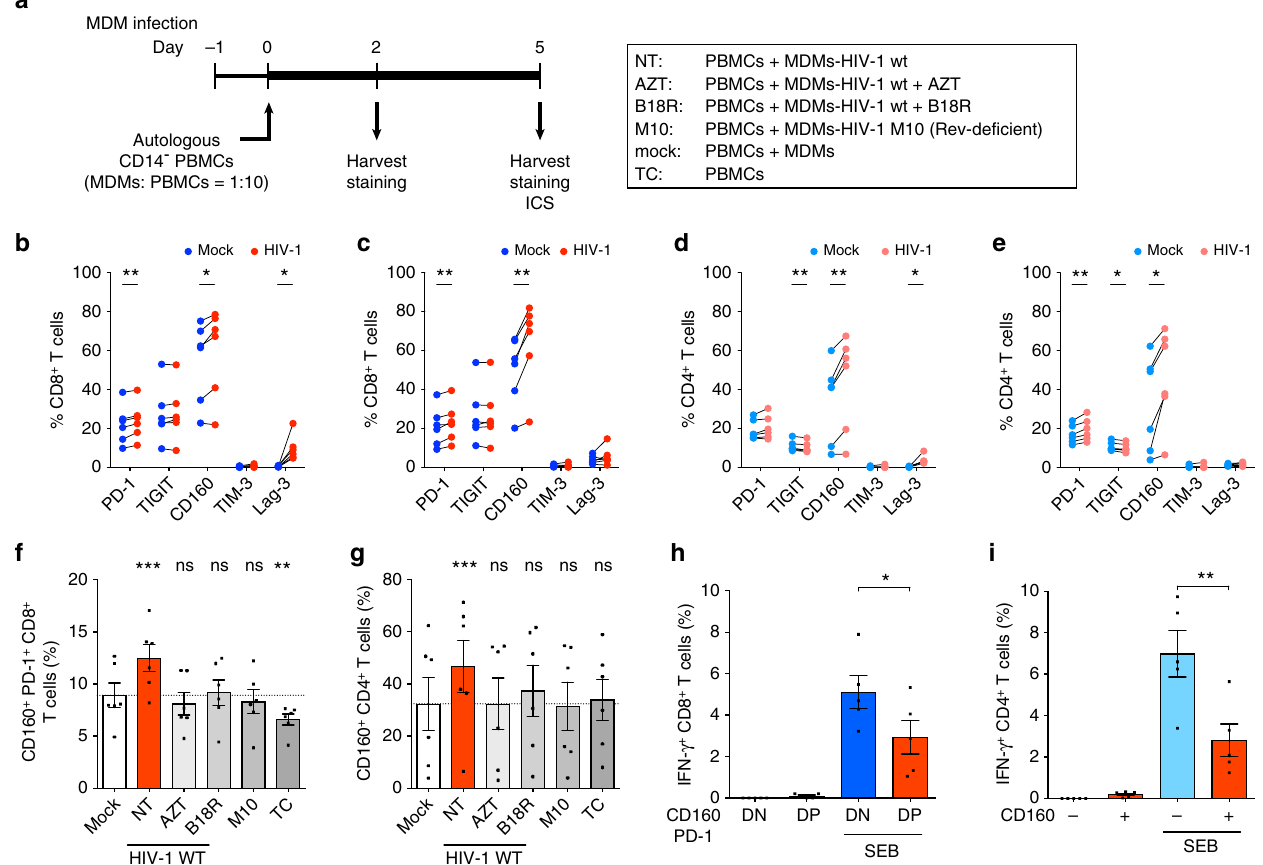
Fig. 6 HIV-1-infection-induced MDM activation results in T-cell dysfunction. a Schematic of T-cell exhaustion immune phenotyping and intracellular cytokine staining (ICS) assay. MDMs were infected with Lai Δ envGFP/G (MOI of 2, wt Rev or M10 Rev) in the presence or absence of AZT or B18R, and autologous CD14 - PBMCs were added to MDMs on day 1 post infection (MDM:PBMC ratio = 1:10). b – g The percentage of IR + CD8 + T cells on day 2 ( b ) or day 5 ( c ), or IR + CD4 + T cells on day 2 ( d ) or day 5 ( e ) post initiation of co-culture. f , g The percentage of CD160 + PD-1 + CD8 + T cells ( f ) and CD160 + CD4 + T cells ( g ) on day 5 post initiation of co-culture. The dotted lines indicate the background levels (mock). h , i The percentage of IFN- γ producing CD160 + PD-1 + (DP) or CD160 - PD-1 - (DN) CD8 + T cells ( h ), or CD160 + or CD160 - CD4 + T cells ( i ) in MDM – TC co-culture 6 h post SEB stimulation. The means ± SEM are shown and each symbol represents an independent experiment. Two-tailed p -values: one-way ANOVA followed by the Tukey-Kramer post-test ( h , i ) or the Dunnett ’ s post-test ( f , g ), or paired t -test ( b – e ). * p < 0.05, ** p < 0.01, *** p < 0.001, ns: not signi fi